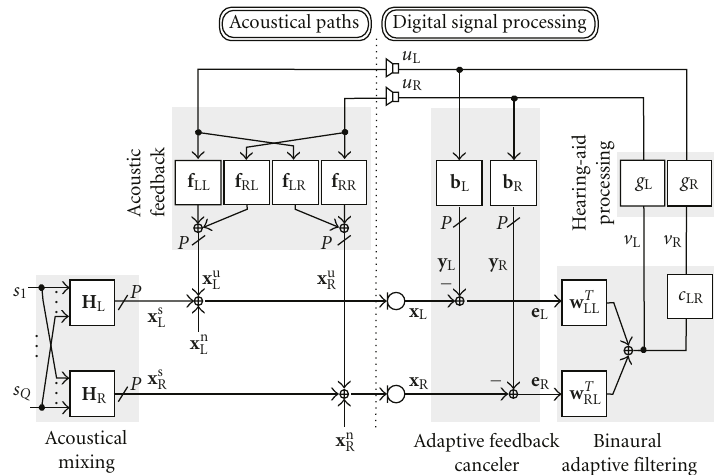
Figure 2: Equivalent signal model of the AFC-BAF combination under the assumption